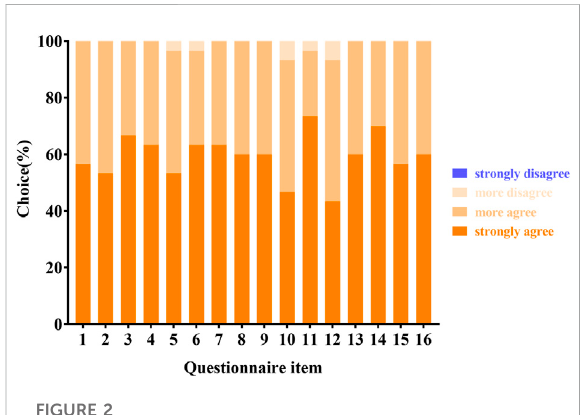
FIGURE 2 Residents ’ feedback to the AI-based PM identi fi cation system with a 4-point